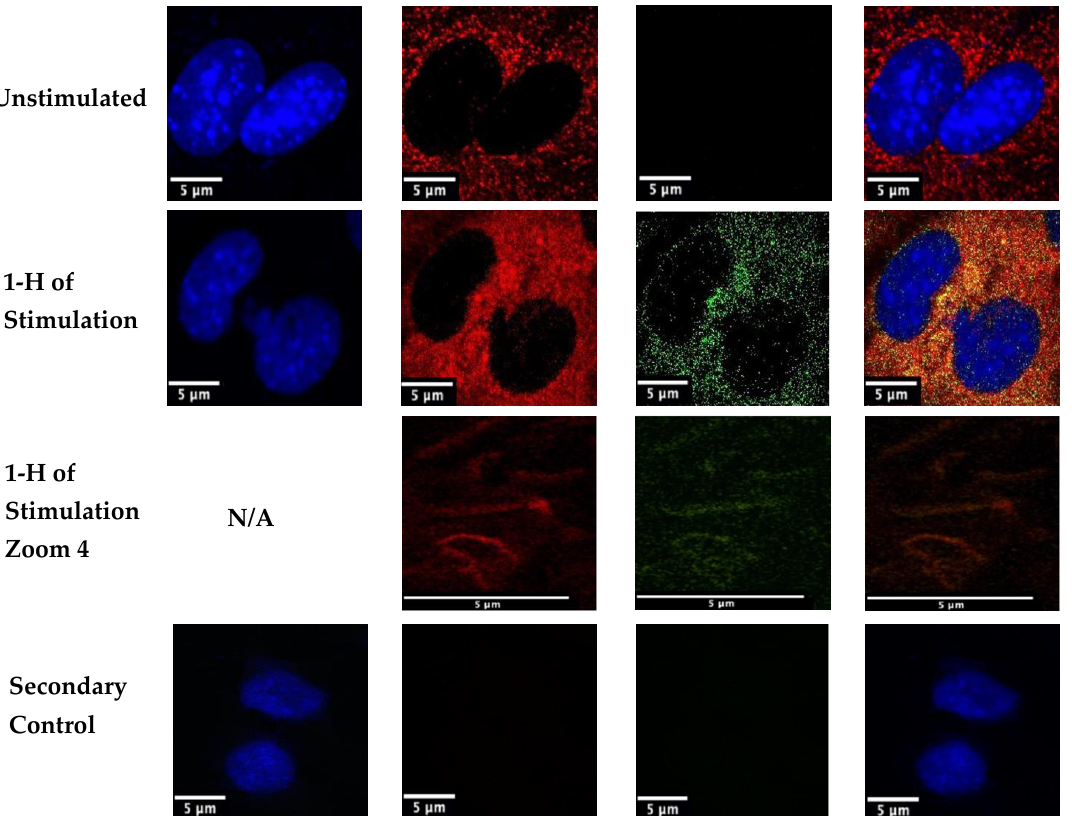
Figure 4. Stimulation of C2C12 cells with BMP-2-QDot ® s for 1 h. Cells were plated at a density of 1 × 10 4 per well and were stimulated or left unstimulated. After stimulation, cells were fixed with 4.4% PFA and BMPRIa (red) and the nuclei (blue) were stained. The nucleus is missing from the ‘ 1h of Stimulation Zoom 4 ’ as the image is taken of the plasma membrane. Confocal microscopic images were taken using the Zeiss LSM710 with the 63×/1.4 objective to determine colocalization (yellow) between BMP-2-QDot ® s and BMPRIa. Each image includes one or two representative cells for each treatment condition. Arrows indicate colocalization. This experiment was repeated independently at least two times.